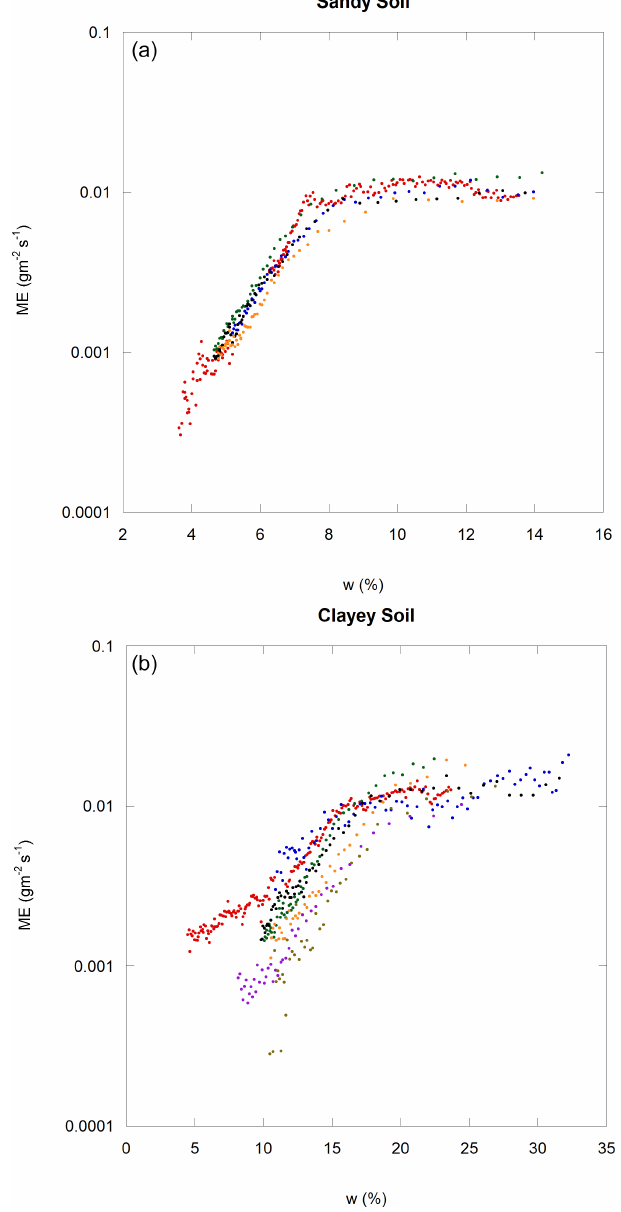
Figure 9. Measured evaporation rate ME versus gravimetric soil moisture (PWM = 30%): (a) sandy soil and (b) clayey soil at sev- eral wind speeds.